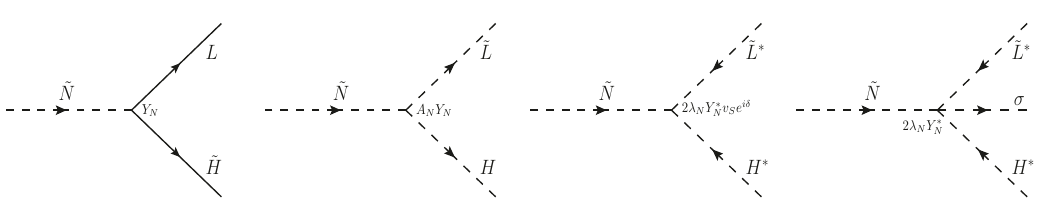
Figure 1 . 2-body and 3-body decay diagrams of a singlet sneutrino, ~ N .